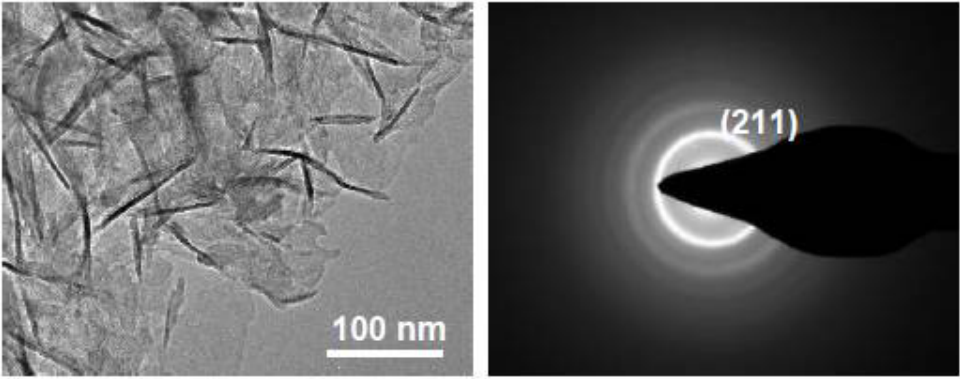
Figure 6. TEM and SEAD images of the bone-like apatite layer.